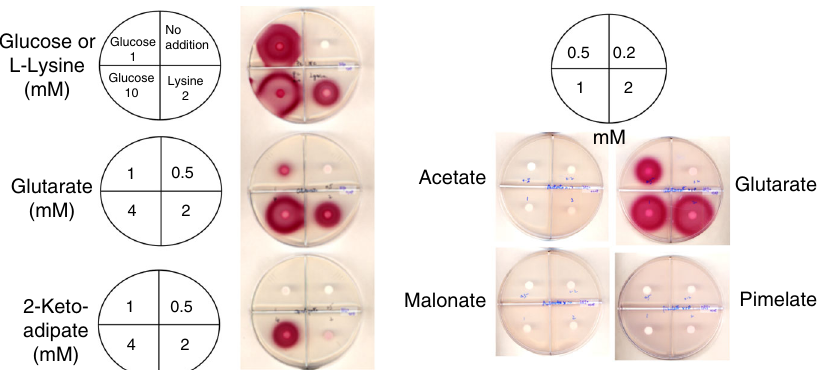
Fig. 8 Resting cells of the A. tumefaciens Δ bioR mutant strain synthesize biotin when supplemented with L -lysine, 2-oxoadipate, or glutarate. No detectable biotin was synthesized by the Δ bioR strain when acetate, malonate, or pimelate were the supplements. The sectors were divided by plastic walls to prevent cross-feeding and the compound incubated with each resting cell sample and their concentration are given on the Figure. Note that addition of glucose allows the resting cells to resume growth. Resting cells were used to avoid the complication of competing reactions and substrates during growth.